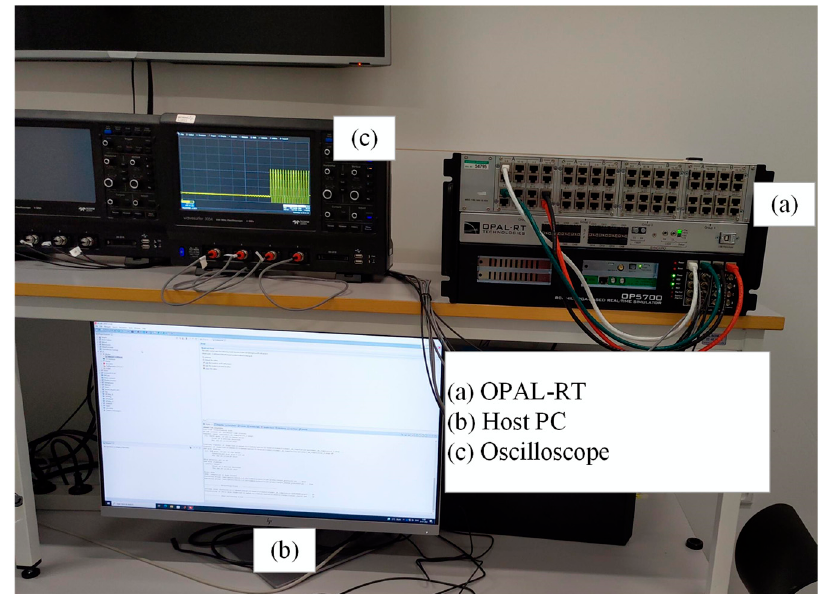
Figure 5. OPAL-RT-based real-time simulation setup.